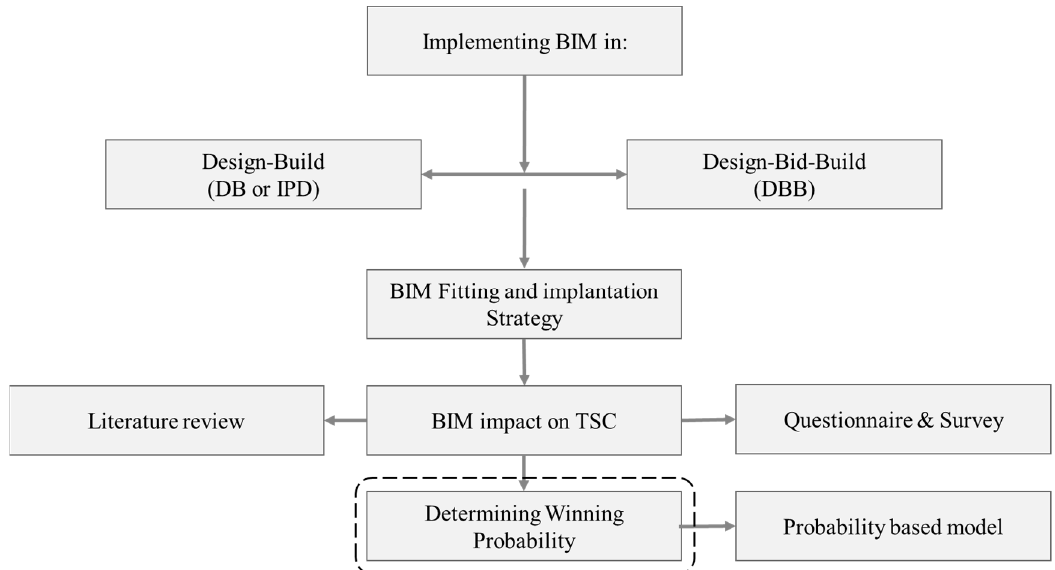
Figure 2. Fitting BIM with PDM.